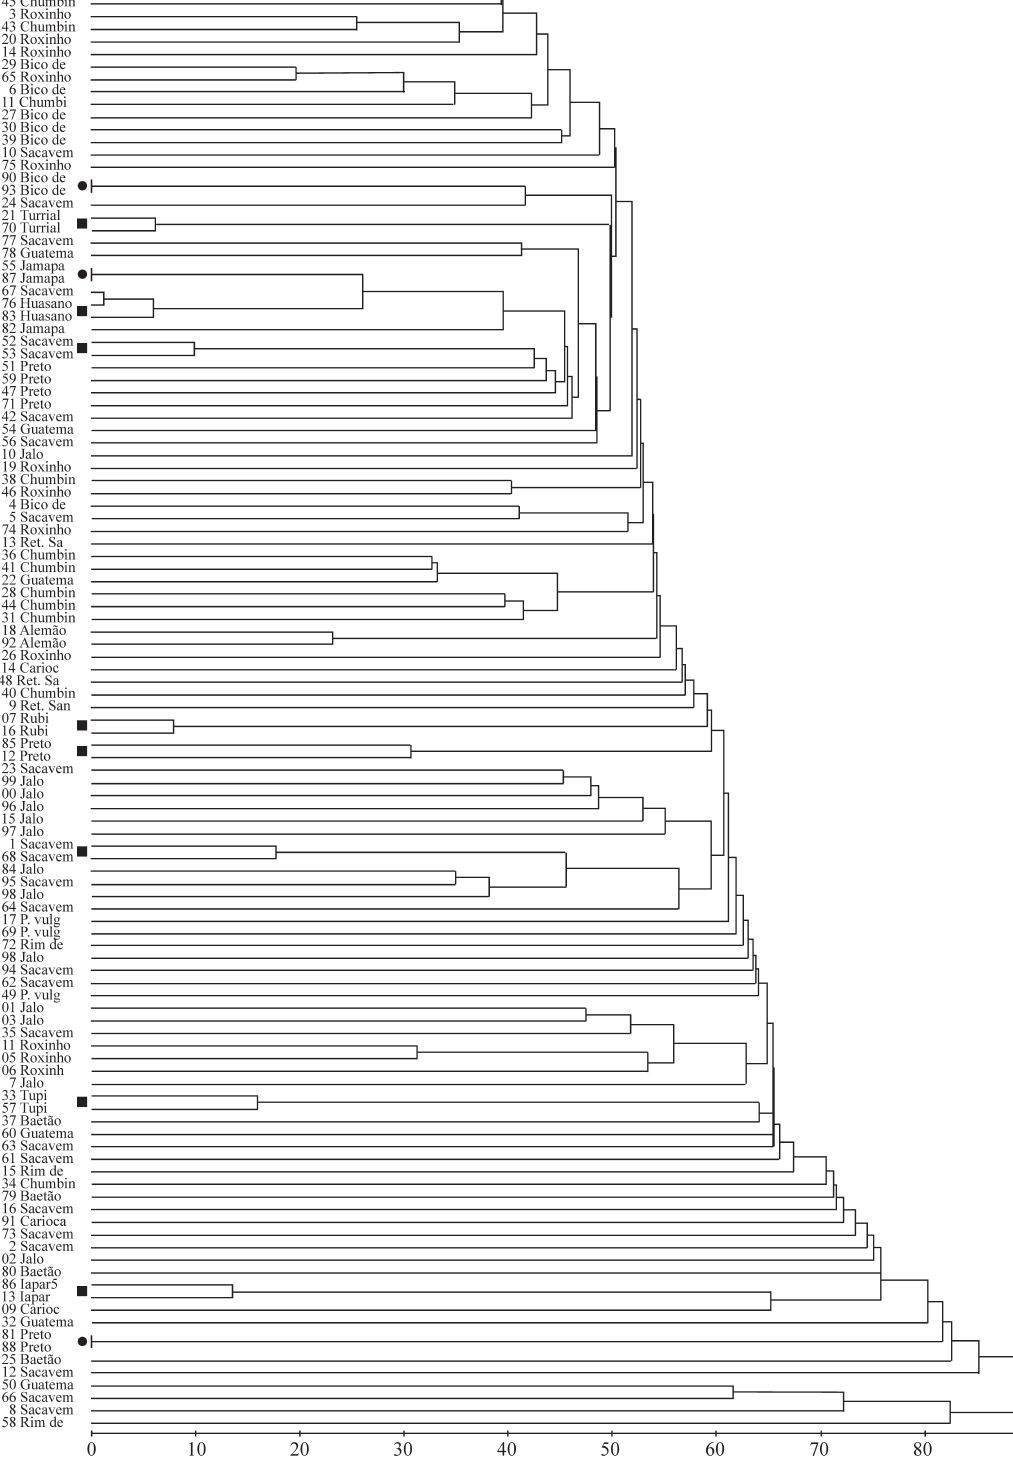
Figure 1 - Single linkage dendrogram based on 17 agromorphological descriptors for 116 common bean accessions from the IAC Germplasm Bank. ( (cid:1) ) Accessions considered duplicates ( (cid:2) ). Accessions suspected of being